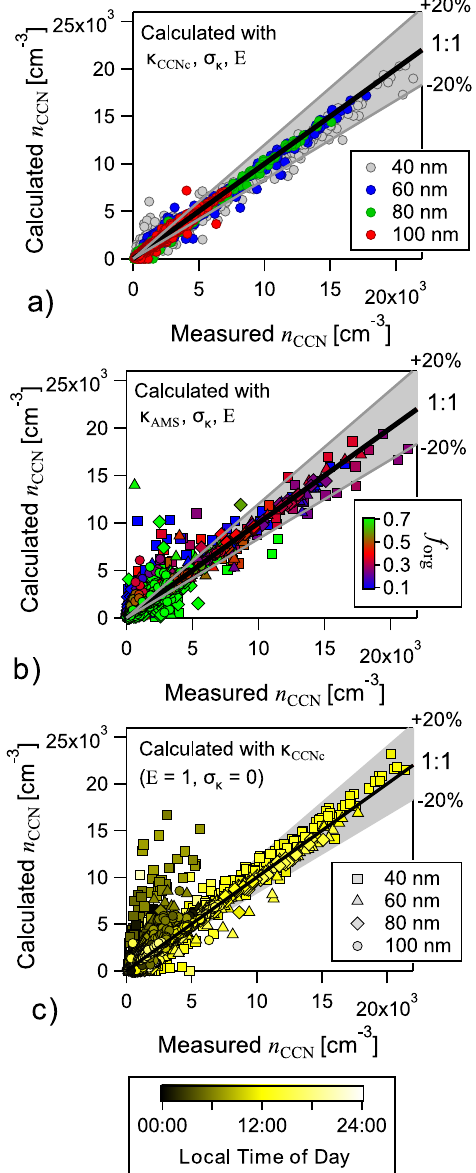
Fig. 9. Size-resolved CCN concentrations calculated from three dif- ferent methods: (a) using d p , σ d , κ CCNc , E and σ κ ; (b) the same as in (a) but using κ AMS instead of κ CCNc ; and (c) the same as in (a) but not accounting for the aerosol chemical heterogeneity ( E = 1 and σ κ = 0). Calculated CCN concentrations are compared to mea- sured CCN concentrations for a given classified particle size. Mark- ers are colored by local time of day in (c)